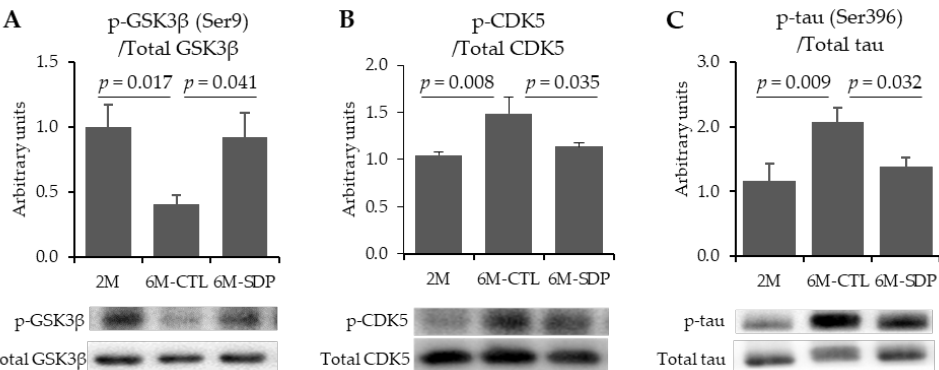
Figure 3. Effect of SDP supplementation on neurofibrillary tangles. Panels ( A – C ) show the abundance of p-GSK3 (Ser9), p-CDK5, and p-tau (Ser396) in the brain tissue, respectively. Results are expressed as mean ±SEM ( n = 5–6 mice). Statistics: one-way ANOVA followed by Fisher’s multiple comparison test. GSK3 : glycogen synthase kinase 3β; CDK5: cyclin de- pendent kinase 5.